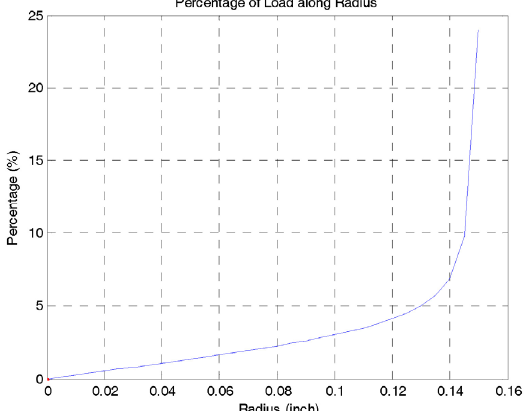
Fig. 10 Pin-to-plate interface with fluid cavities and contact